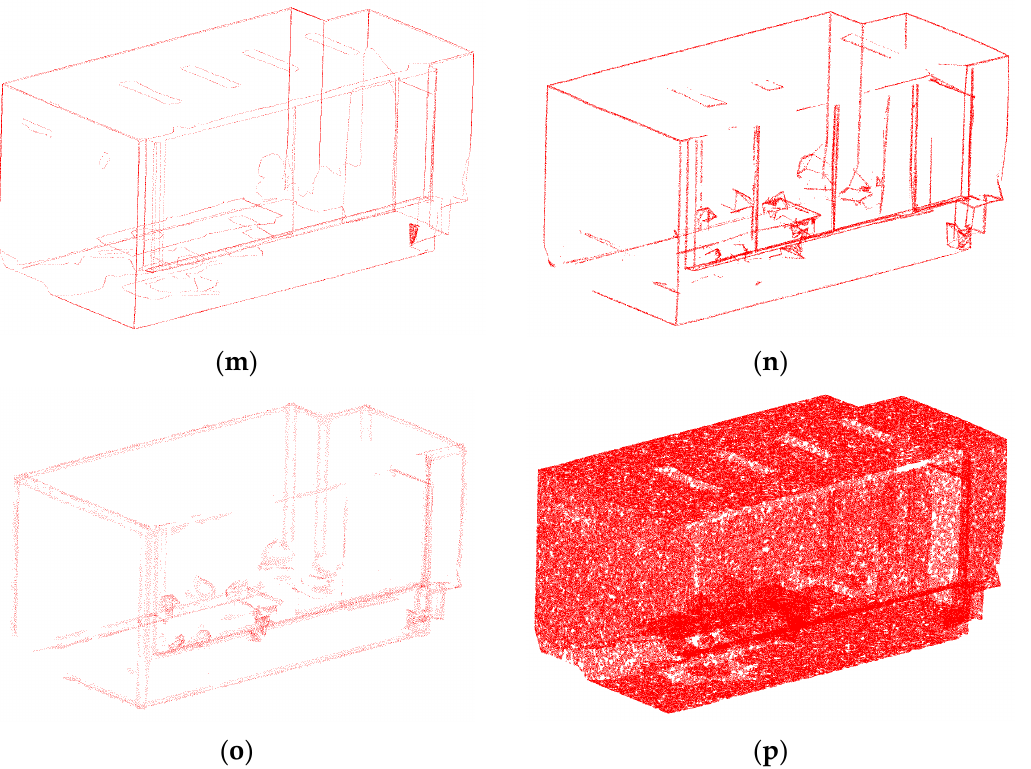
Figure 15. Comparison of contour point extraction effects of different methods. Among them, ( a , e , i , m ) are the contour points extracted based on the proposed method; ( b , f , j , n ) are the contour points extracted by the method proposed by Bazazian et al. [15]; ( c , g , k , o ) are the contour points extracted by the method proposed by Ioannou et al. [16]; ( d , h , l , p ) are the contour points extracted based on Statistical Outlier Removal filter. Table 3. Contour point extraction results of four indoor scenes by different methods.